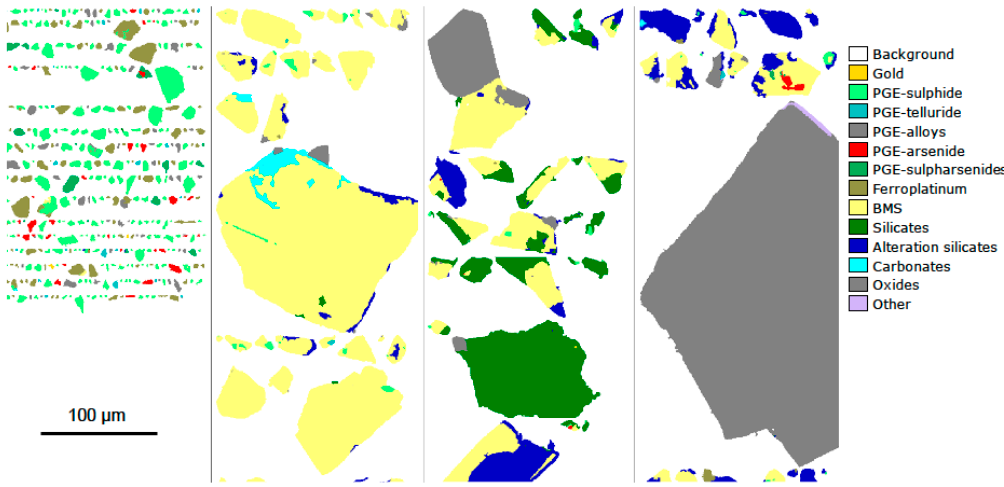
Figure 13. MLA false-color images of the various mineral particles in the plant products. The first column shows the liberated platinum-group minerals, the second column shows some examples of sulphides and associated platinum-group minerals, and columns 3 and 4 display various silicate and oxide minerals (many with associated sulphides).